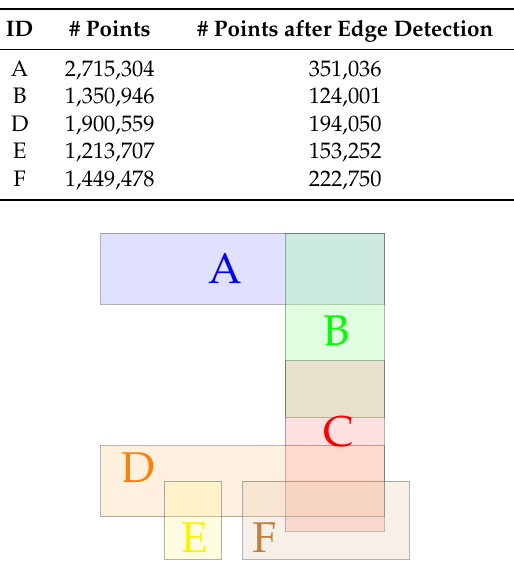
Figure 3. Relative positions of dataset